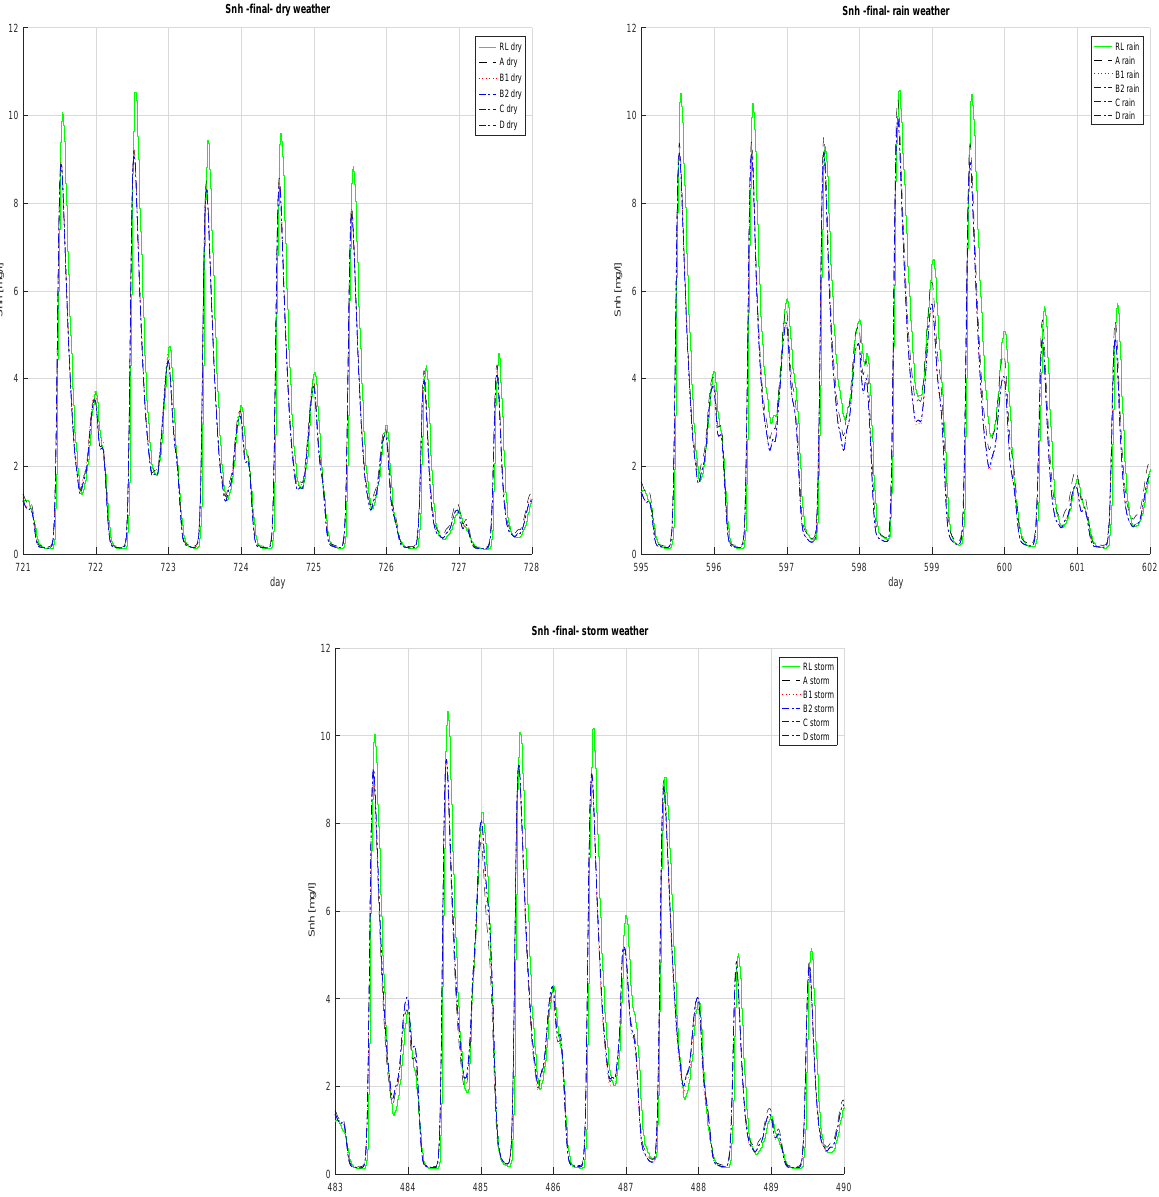
Figure 12. S NH concentration for the final